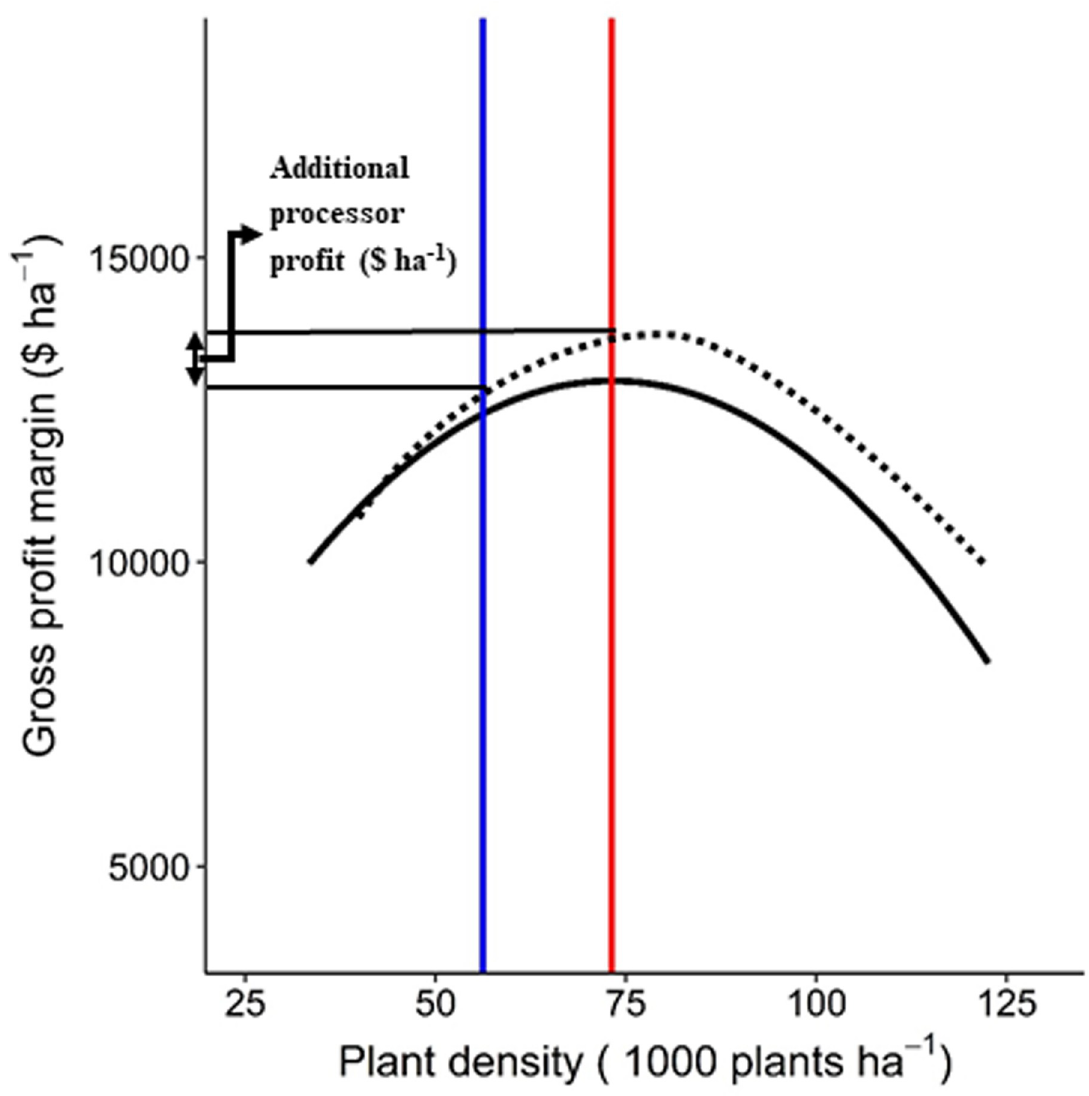
Fig 2. Calculation of additional processor profit ($ ha -1 ) for a field in a given level of a recommendation domain model (RDM). Red line represents the optimum plant density (plants ha -1 ) for maximum gross profit margin ($ ha -1 ) under a level of a RDM (solid black curve). Blue line represents current plant density for an individual field (dotted black curve). The difference in gross profit margin observed at the optimum plant density under RDM level and current plant density of a field give additional processor profit from the